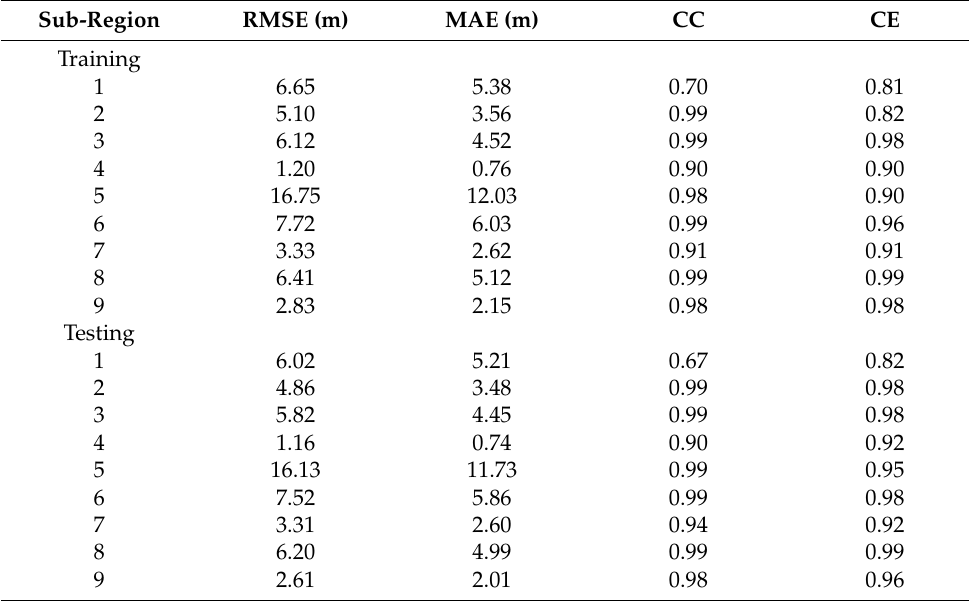
Table 3. RMSE, MAE, CC, and CE of SVM-MSF in training and testing sections.